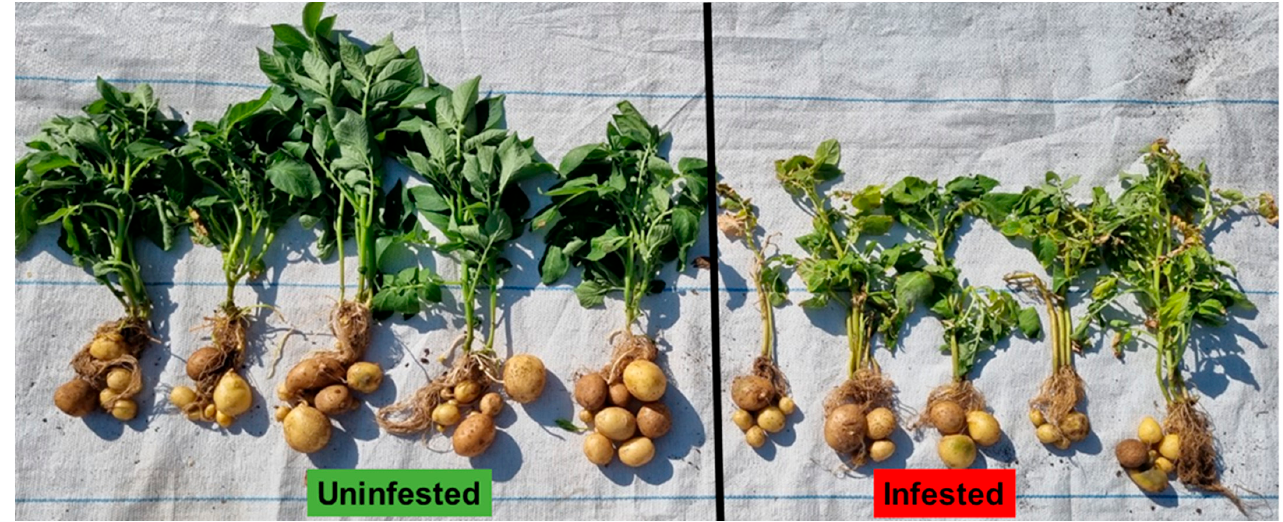
Figure 7. Yield comparison between the uninfested and Tuta absoluta -infested potato plants.